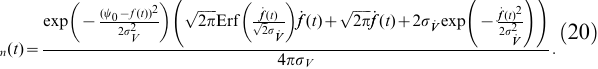
V ffiffiffiffiffiffiffiffiffiffiffiffiffiffiffiffiffiffiffiffiffiffiffiffiffiffi C (0) = p . j C ’’ (0) j